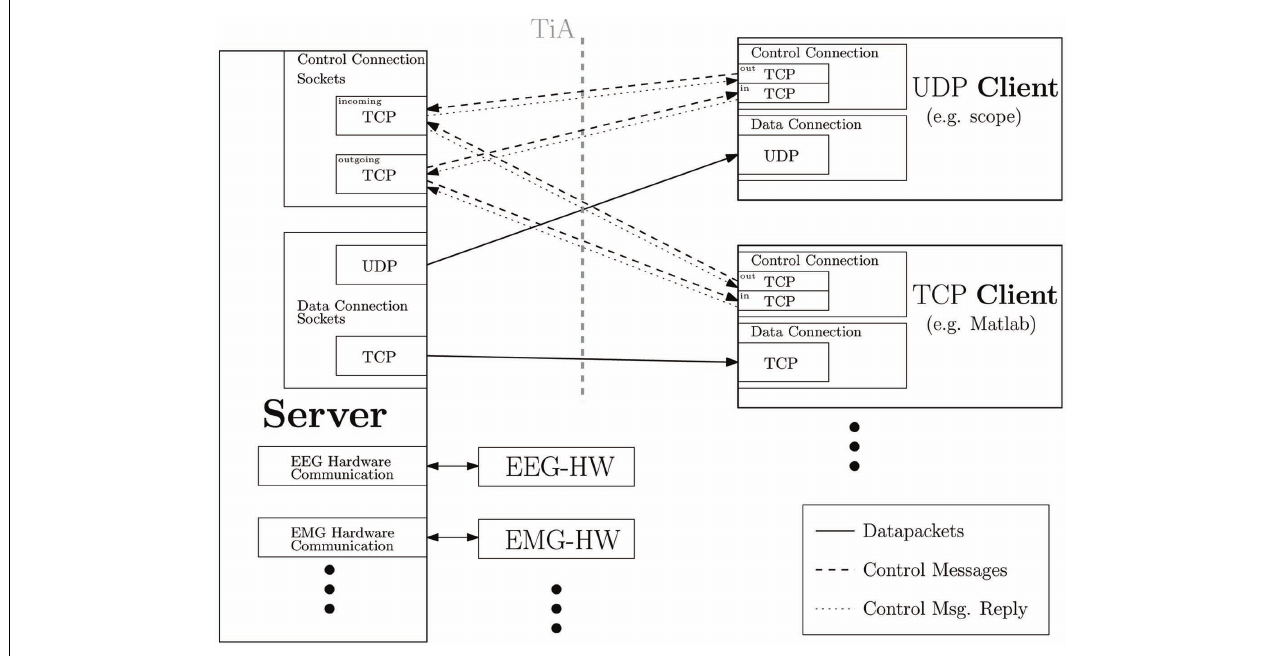
FIGURE 3 |Working scheme of the data acquisition server. Clients can connect to the server and will be configured through control messages, sent